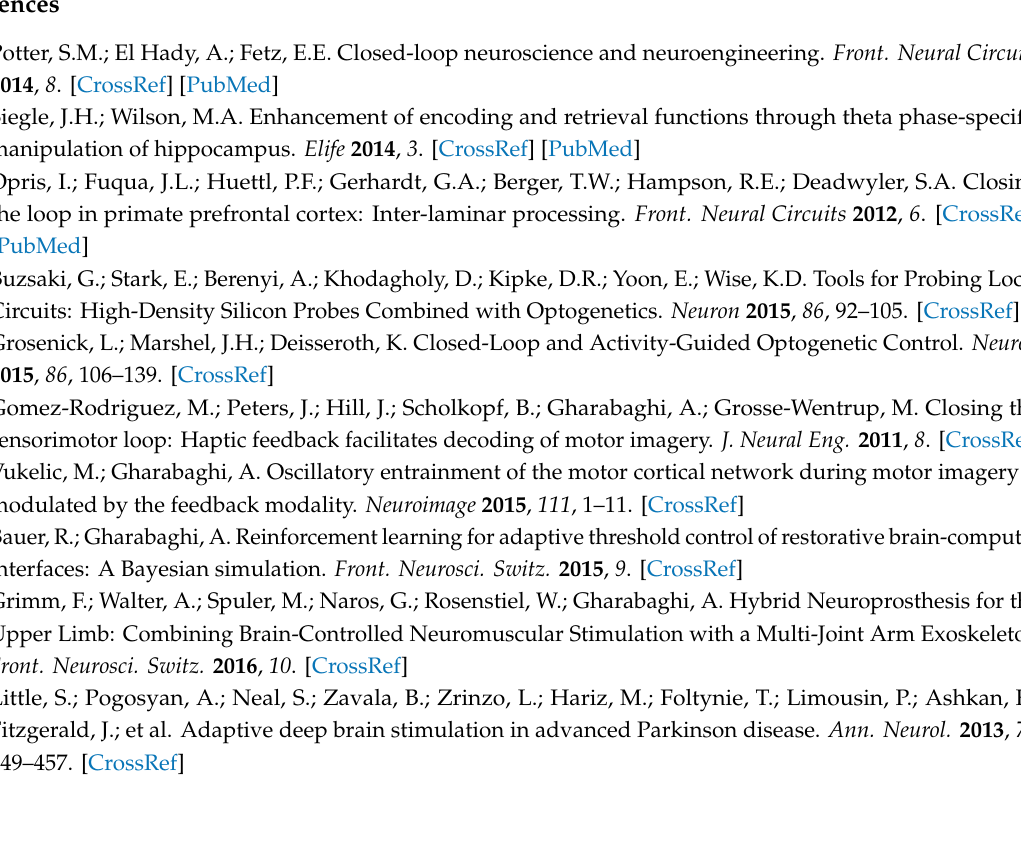
Table S1: PRISMA 2009